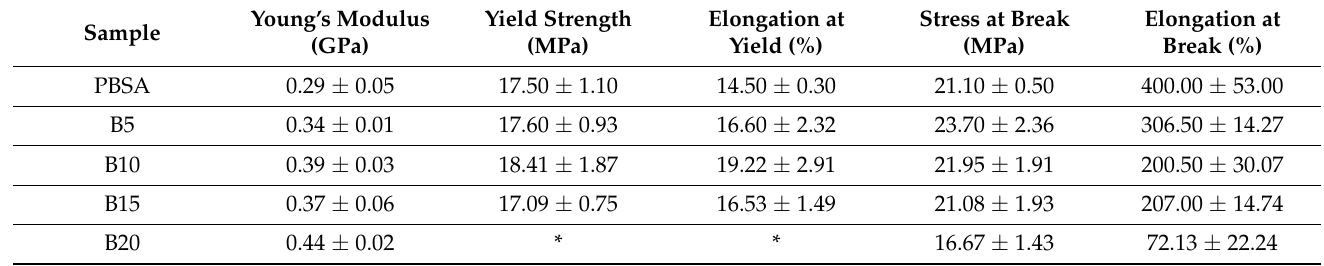
Figure 10. Stereo microscope images of the PBSA/B composite pellets. Table 2. The tensile properties of the PBSA and PBSA/B composites. The mean value ± standard deviation of five